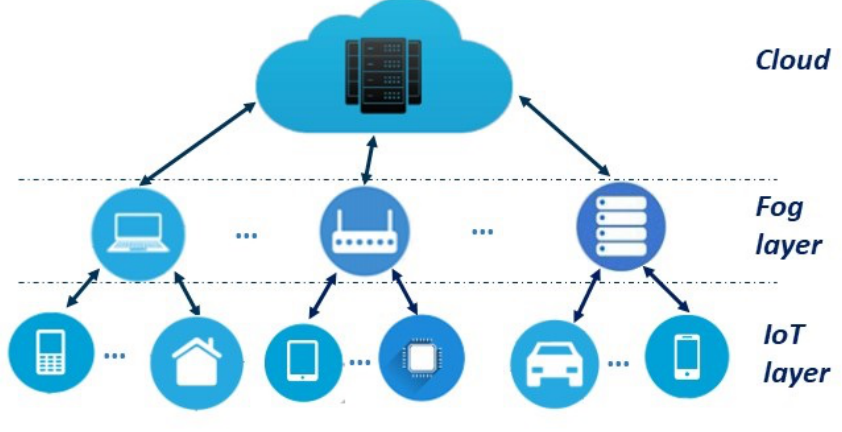
Figure 2. IoT system